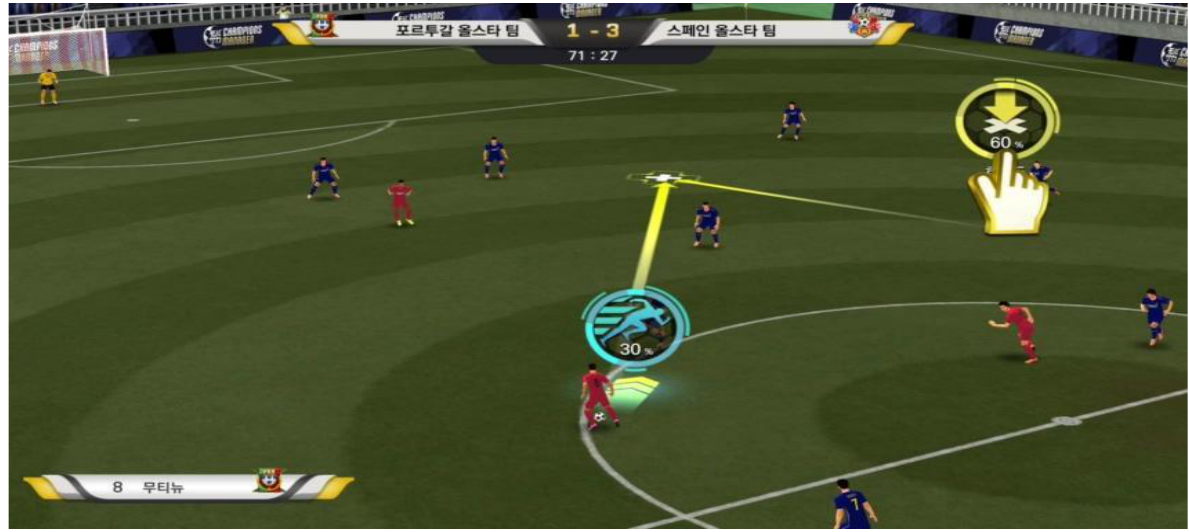
Figure 1. Champions Manager Mobasaka gameplay.